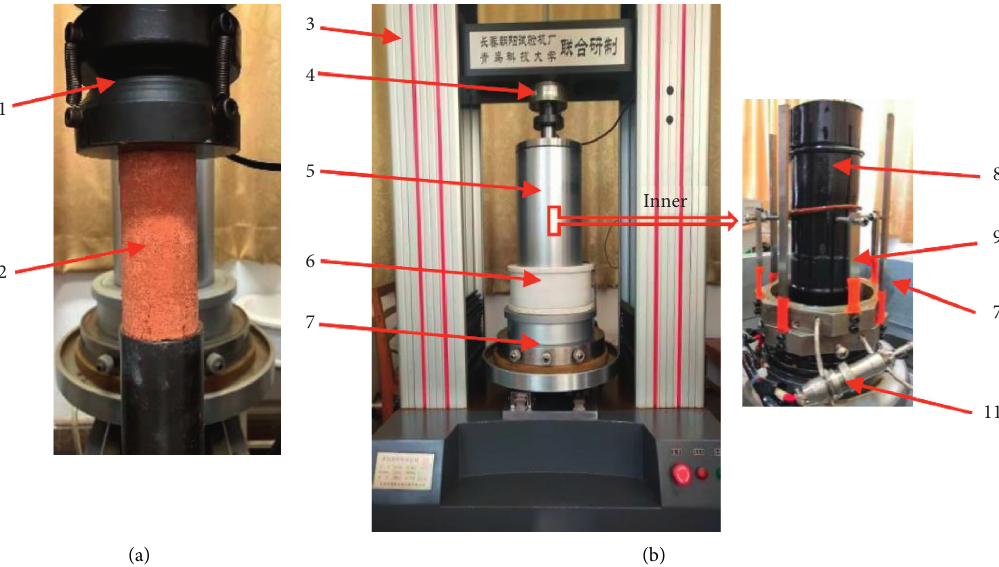
Figure 3: TAW-200 electronic multifunctional material mechanics testing machine: (a) UCT; (b) TCT.1, press ram; 2, sandstone sample; 3, reaction frame system; 4, pressure sensors; 5, confining pressure cylinder; 6, electromagnetic heating; 7, lantern ring; 8, heat-shrink pipe; 9, radial displacement transducers; 11, temperature transmitter.